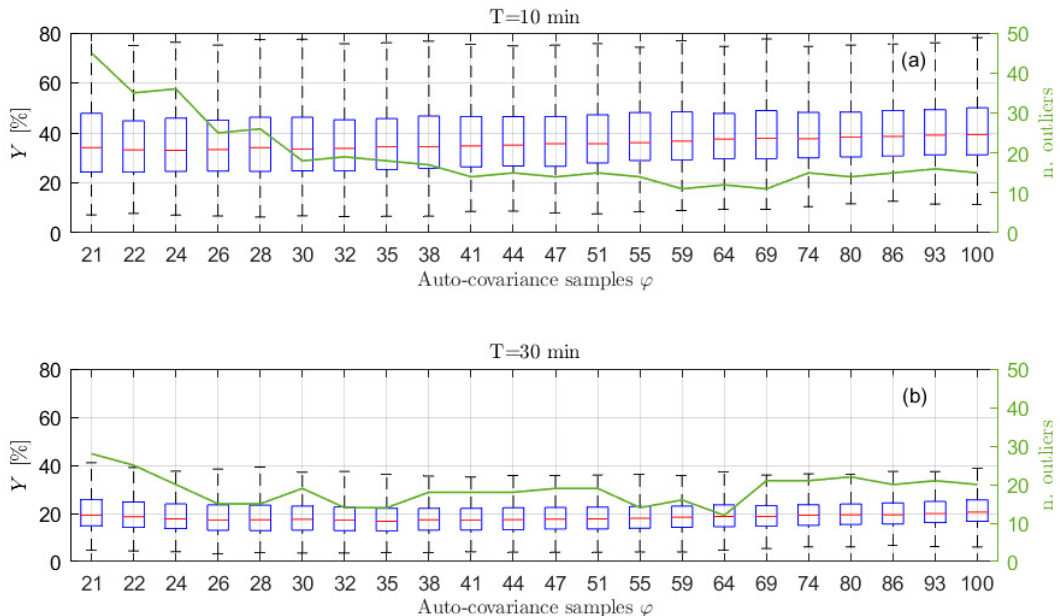
Figure 8. Box plot (left vertical axis) and number of outliers (solid line and right vertical axis) as functions of the number ϕ of auto − covariance samples used to write Equation (14) obtained using ˆ p = 10 and signals of type 1 in Table 1, sampled at 1 Hz for 600 s ( a ) and 1800 s ( b ). The typical values of ˆ ϕ are between 25 and 27 for 30 min time series and between 17 and 25 for 10 min.